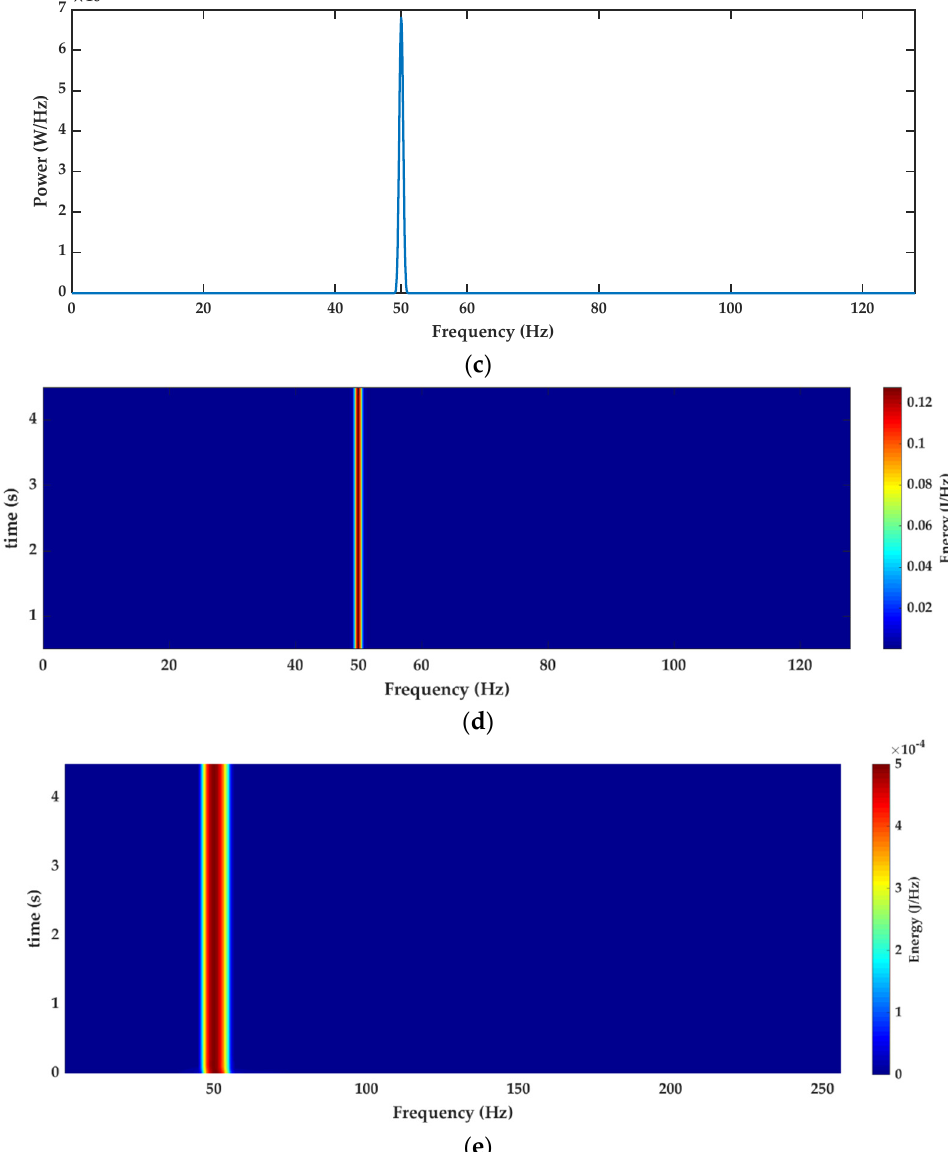
Figure 5. Results for the first scenario (no noise). ( a ) Estimation error 0.06%, ( b ) Estimation error 0.04%, ( c ) Estimation error 0.02%, ( d ) Estimation error 0.12%, ( e ) Estimation error 0.2%.